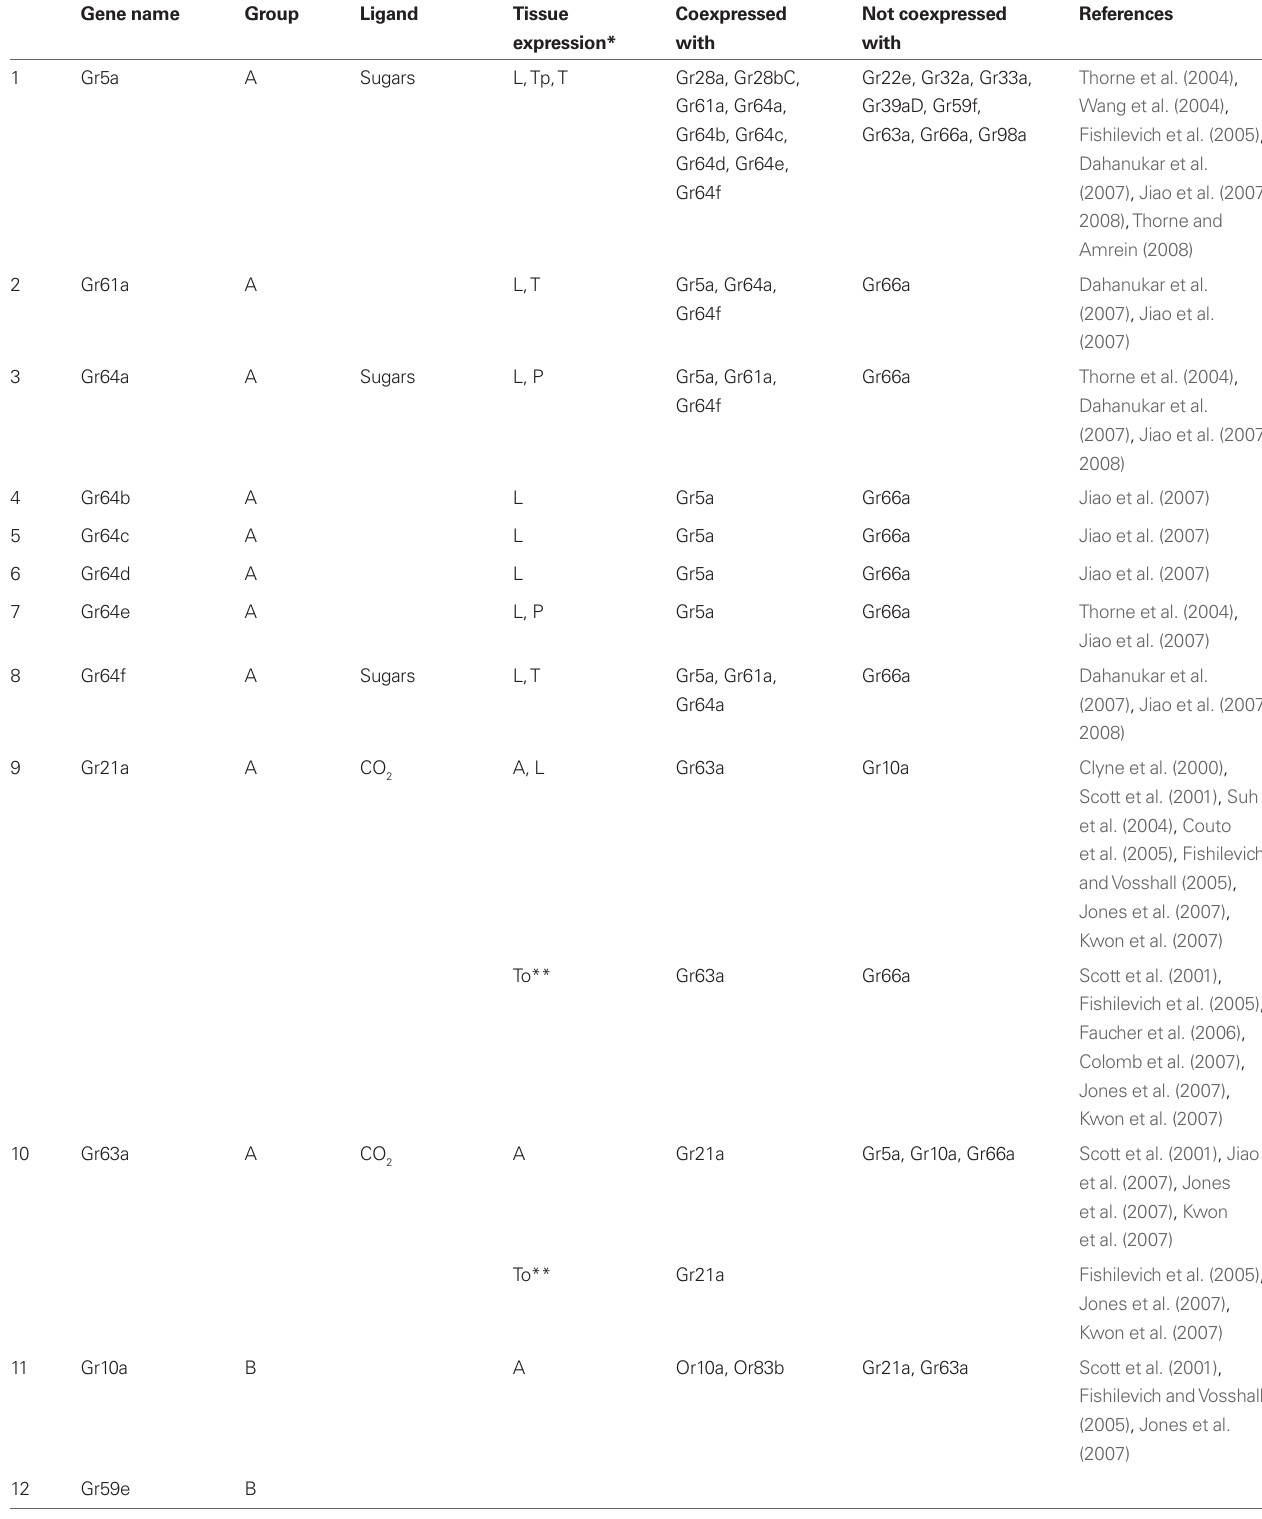
Table 1 | Gustatory receptor genes in the genome assembly of Drosophila melanogaster with their phylogenetic relations, functions and neuronal expression